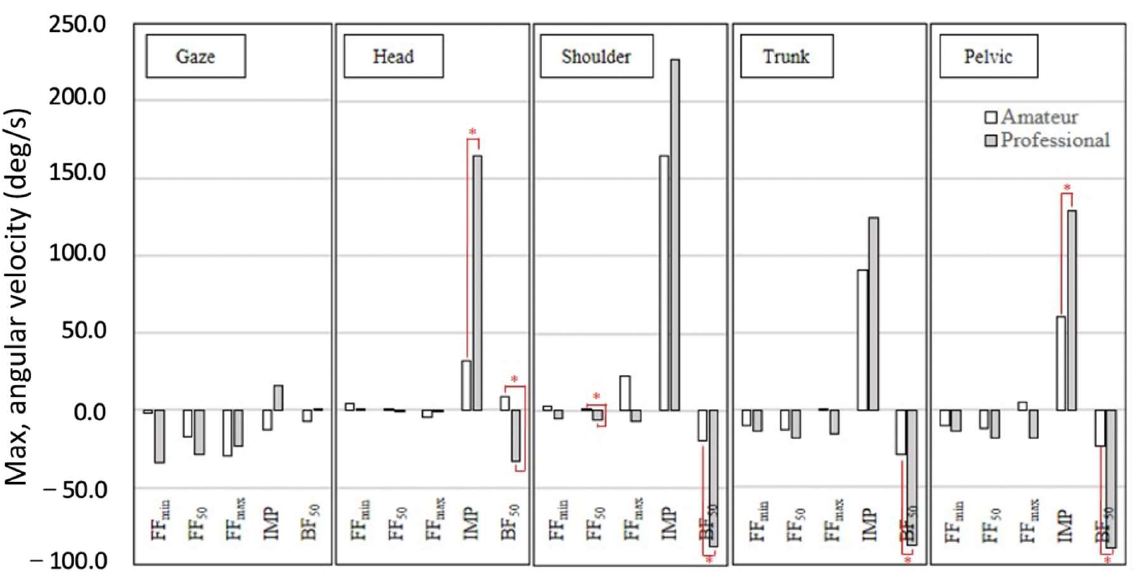
Figure 4. The angular velocity of the amateur and professional groups of the five key events of the head, shoulders, trunk, pelvis, and gaze. (*: p < 0.05).